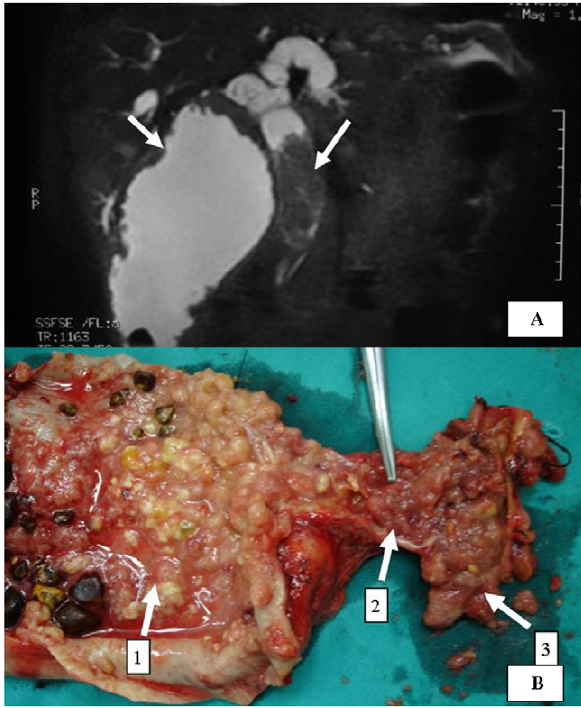
Figure 3. A jaundiced gallbladder carcinoma with tumor thrombus in common bile duct. (A: MRCP photography shows filling defect in CBD and gallbladder; B: In surgery specimen arrows 1–3 point at tumor tissues in gallbladder, cystic duct and CBD respectively.) We state that the subject of the photograph has given written informed consent by the patient to publication of the photograph.